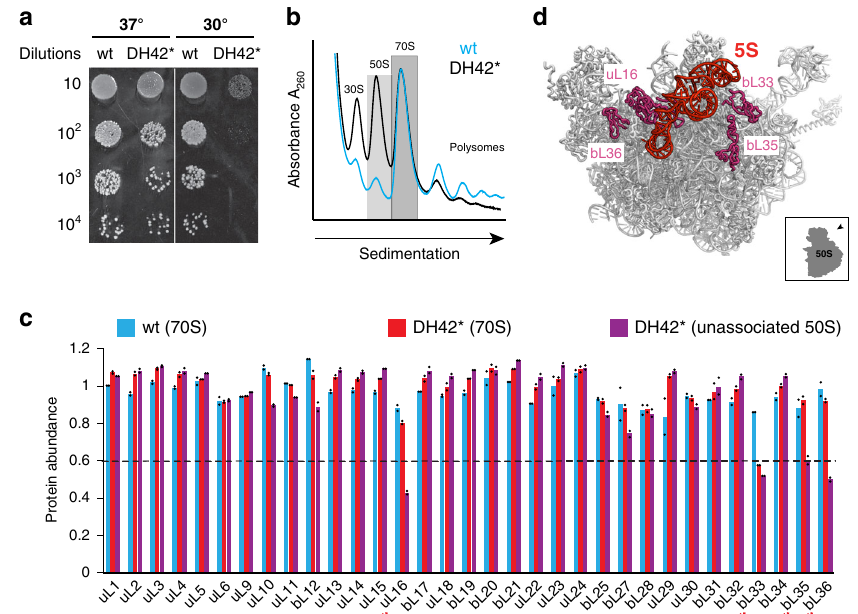
Fig. 5 The lack of free 5S rRNA results in assembly defects. a Cold sensitivity of cells expressing 23S-cp5S ribosomes. Exponentially-growing cultures of wt or DH42* cells were serially diluted and spotted onto LB/agar plates supplemented with Amp. Plates were incubated at 37°C for 24h or at 30°C for 48h. b Sucrose gradient analysis of ribosomal fractions isolated from wt or 23S-cp5S DH42* cells. Fractions shaded with dark (70S) and light (unassociated 50S subunits) gray boxes were collected for subsequent analysis. c Protein composition of the large subunits in wt (blue bars) or mutant (red bars) 70S ribosomes and of the unassociated mutant 50S subunits (purple bars). Red asterisks indicate the r-proteins that are signi fi cantly underrepresented (<60% of the remaining amount) in the unassociated 50S subunits. The bar graph represents the mean of two biological replicates with individual data points indicated by black dots. Raw data can be found in the Source Data fi le. d Relative location of the 5S rRNA (red) and underrepresented proteins (purple) in the large subunit structure viewed from the solvent